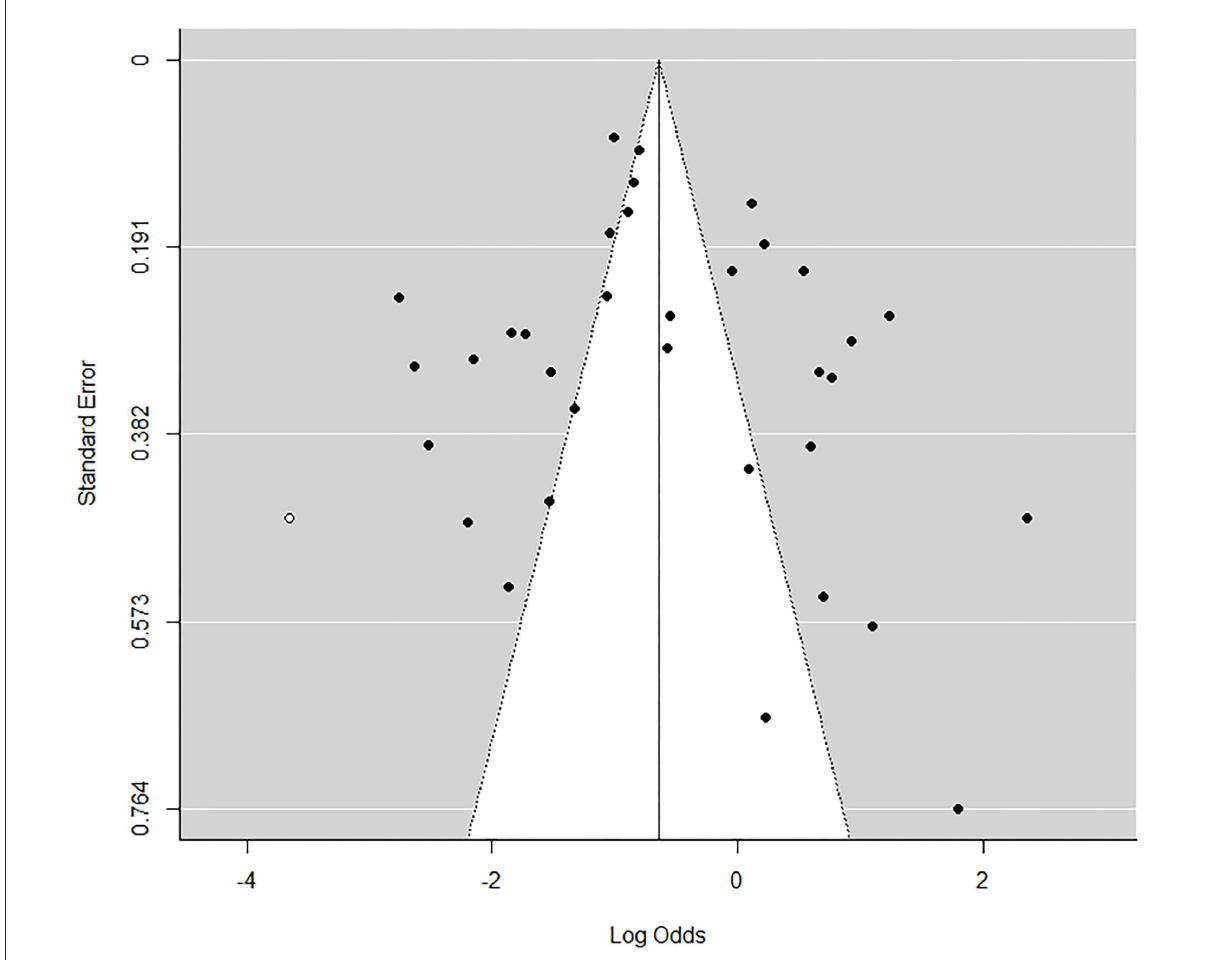
FIGURE6 Antimicrobial resistance rate of Staphylococcus aureus